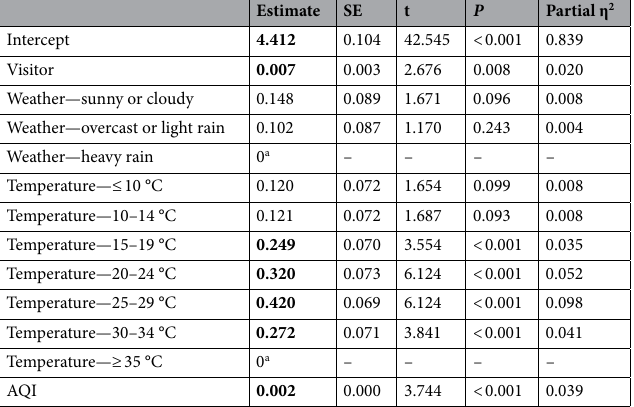
Table 1. The regression model exploring air pollution effects on social conflict (Ln) of monkeys in Nanjing Hongshan Zoo in China. Significant results were marked bold. a This parameter is set to zero because it is redundant.